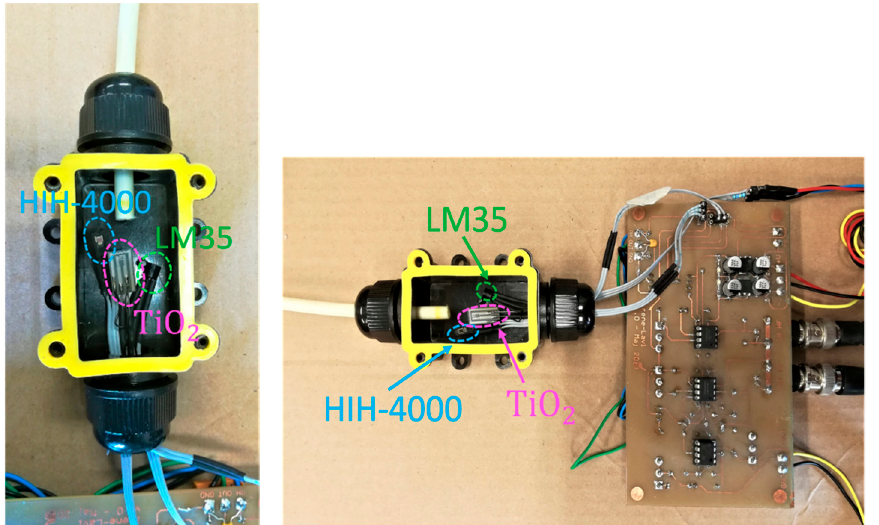
Figure 3. Front-end circuit used during the acquisition with the IP68 measurement chamber; inside the chamber are housed the temperature sensor LM35 (highlighted in green), the humidity sensor HIH-4000 (highlighted in blue) and the functionalized substrate (highlighted in magenta).